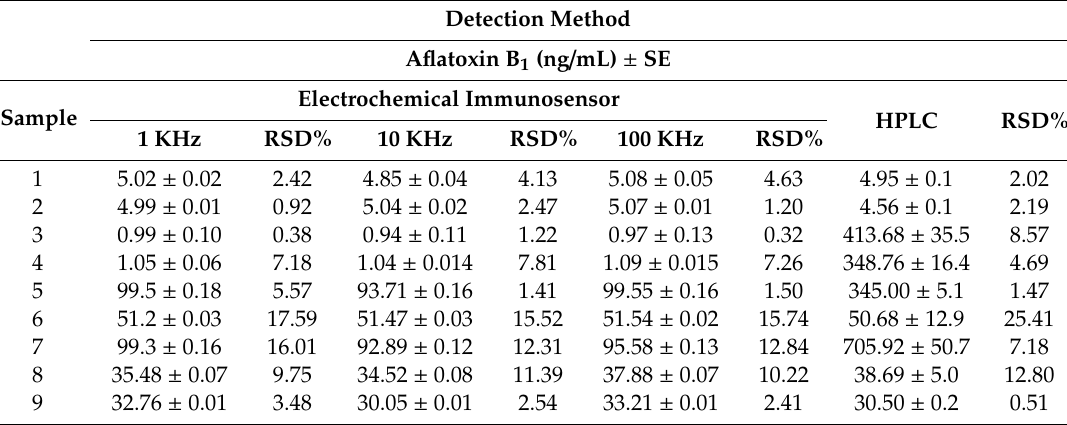
Table 3. Aflatoxin B 1 concentrations and Percentage of Relative Standard Deviations (RSD%) in pistachio samples as measured by the immunosensor and HPLC ( n = 3, mean ± SD).